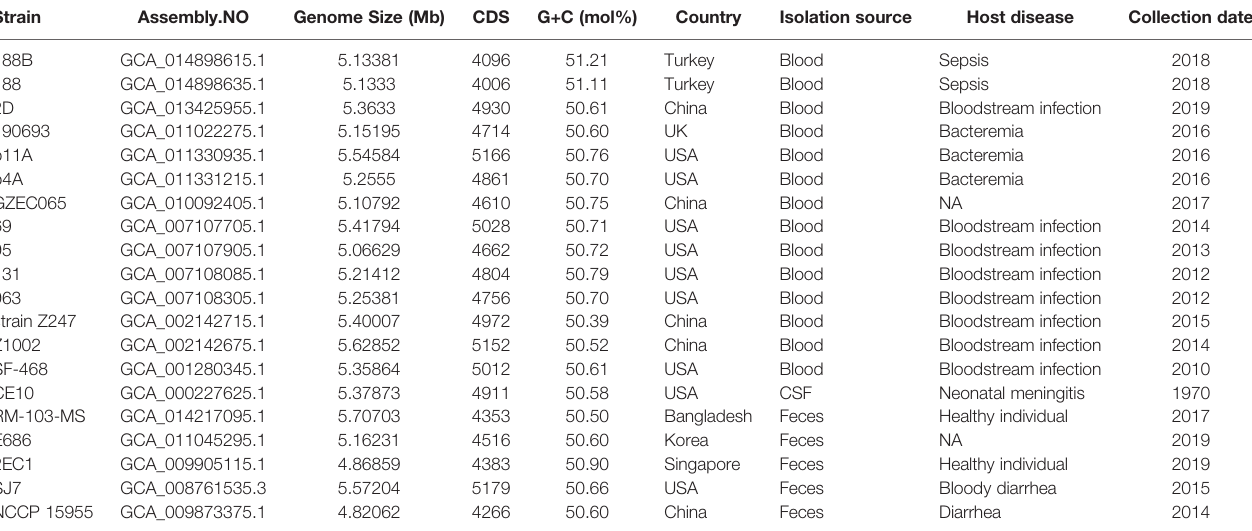
TABLE 1 | Genome statistical information of the 20 Escherichia coli strains selected from NCBI. Strain